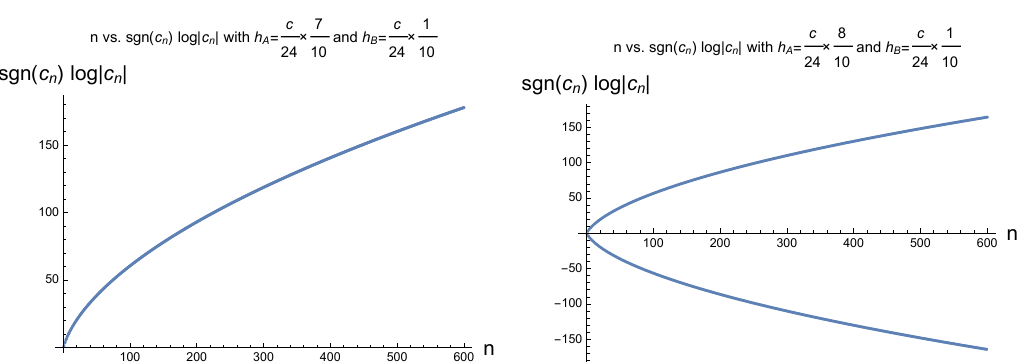
Figure 4 . The sign behaviors of coefficients c n . Actually, we plotted sign( c n ) · log | c n | against n for n ≤ 600. The left plot is for ( h A , h B ) = c (0 . 7 , 0 . 1), which is in the region (iii) and c n is always posi- 24 (0 . 8 , 0 . 1), which is in the region (ii) and has alternating signs. tive. The right one is for ( h A , h B ) = c 24